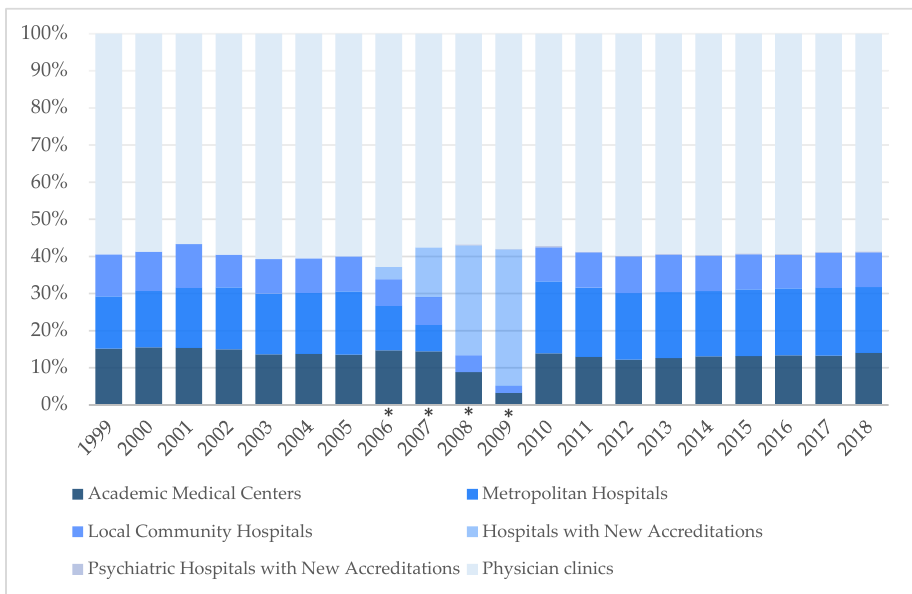
Figure 4. Distribution of family physicians in various practice settings in Taiwan from 1999 to 2018. *Marked transitions in the accreditation regulations in 2006–2009.